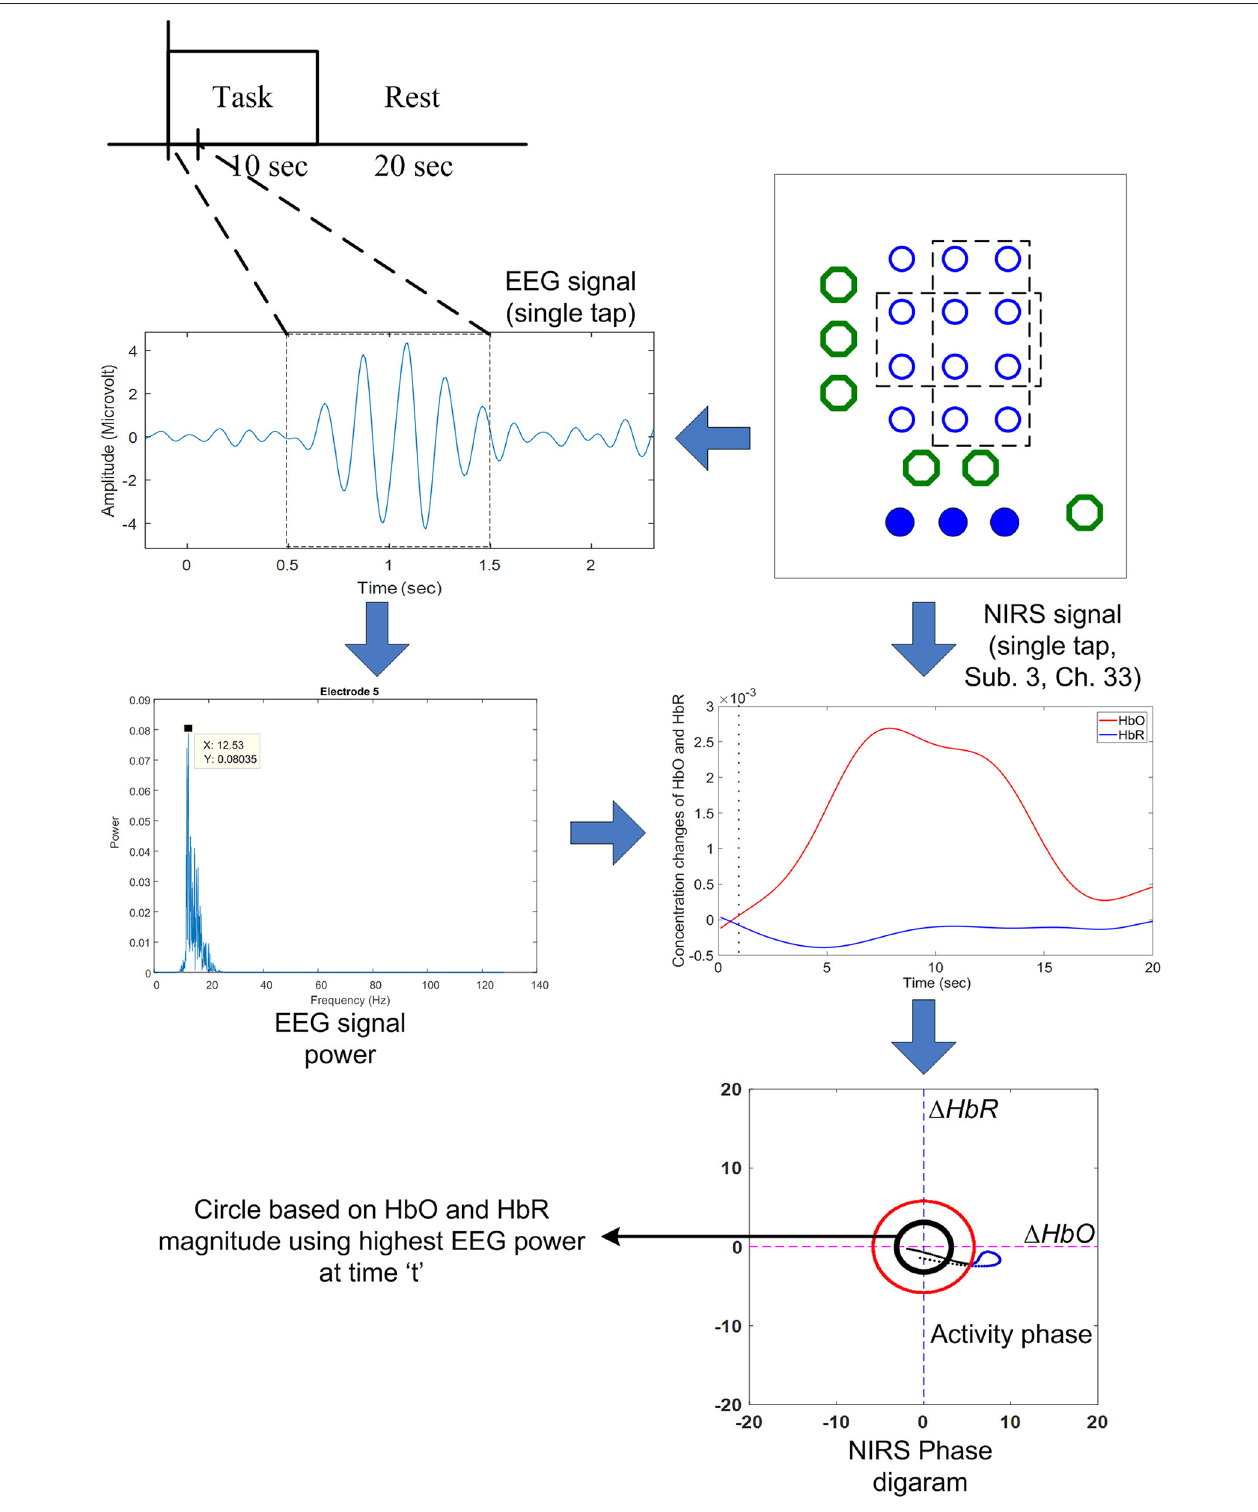
FIGURE 4 | The proposed scheme to predict the early hemodynamic response using the highest EEG power obtained from the 1s time window: If the EEG power is over a certain threshold value, the (black) threshold circle is drawn using Equation (6).